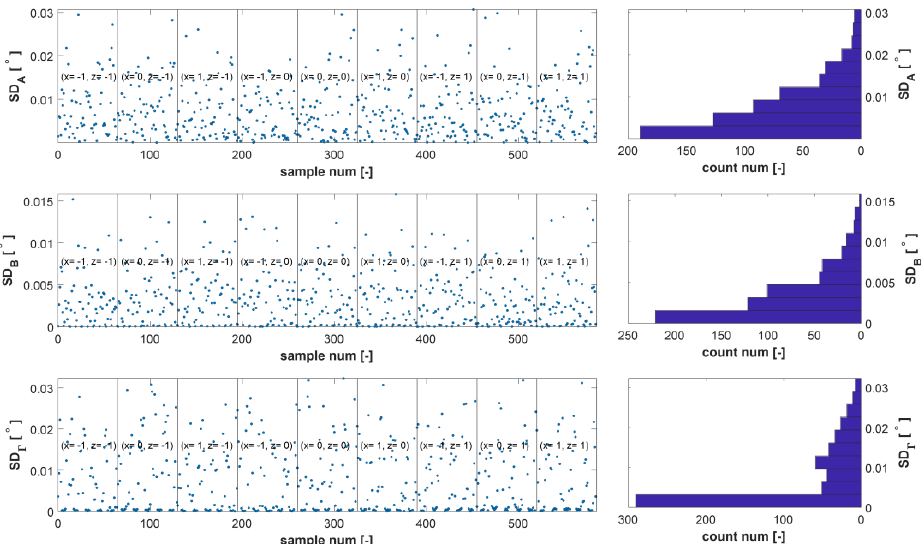
Figure 11. The precision of the tracker orientation measurements for the individual components ( left ) and their histograms ( right ).